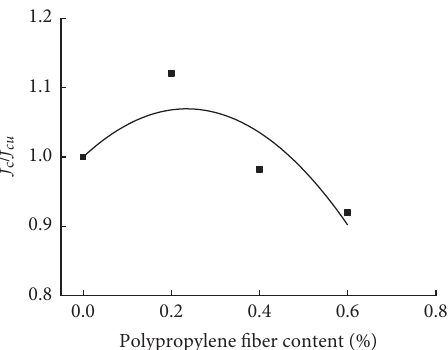
Figure 6: Relationship between polypropylene fiber content and stress variation